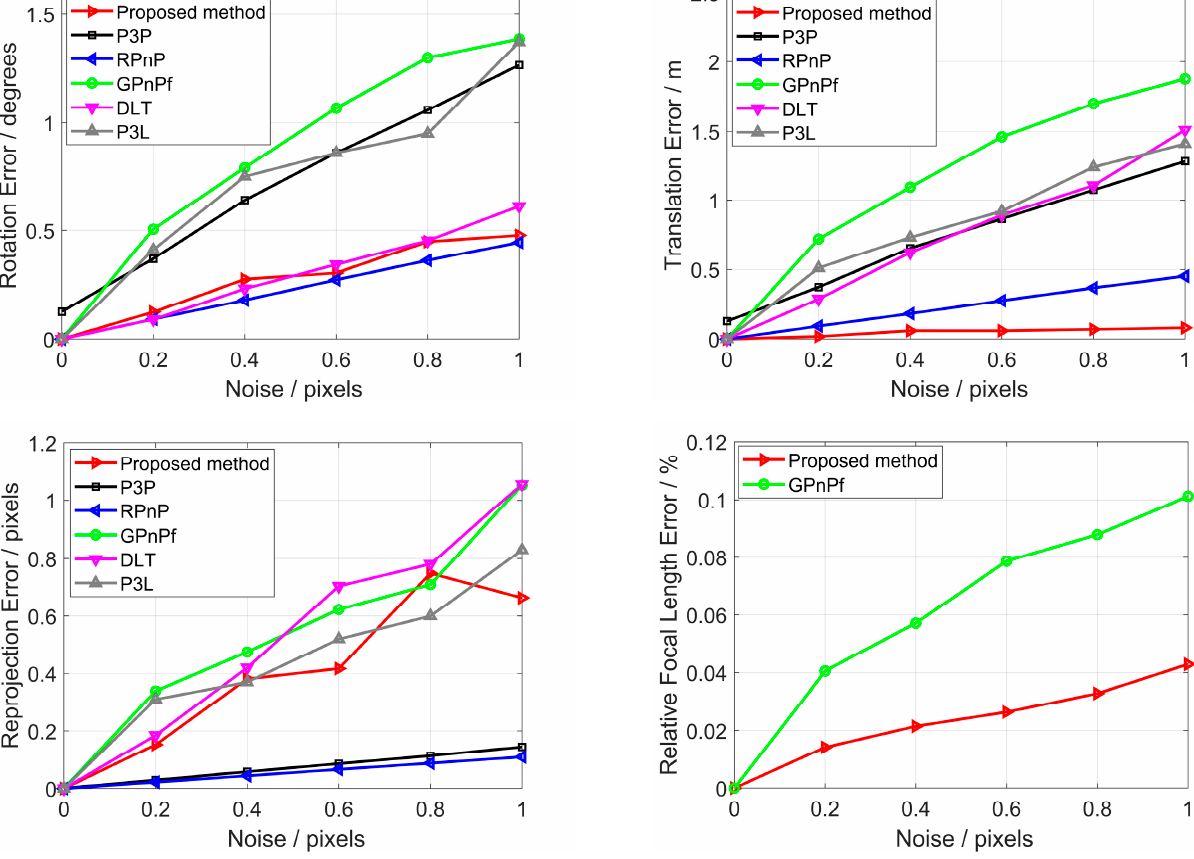
Figure 8. Noise sensitivity for our proposed method (red), P3P (black), RPnP (blue), GPnPf (green), DLT (purple) and P3L (gray). The ( top left ) is the rotation error, the ( top right ) is the translation error, the ( bottom left ) is the reprojection error, and the ( bottom right ) is the focal length error. Table 1. Computational